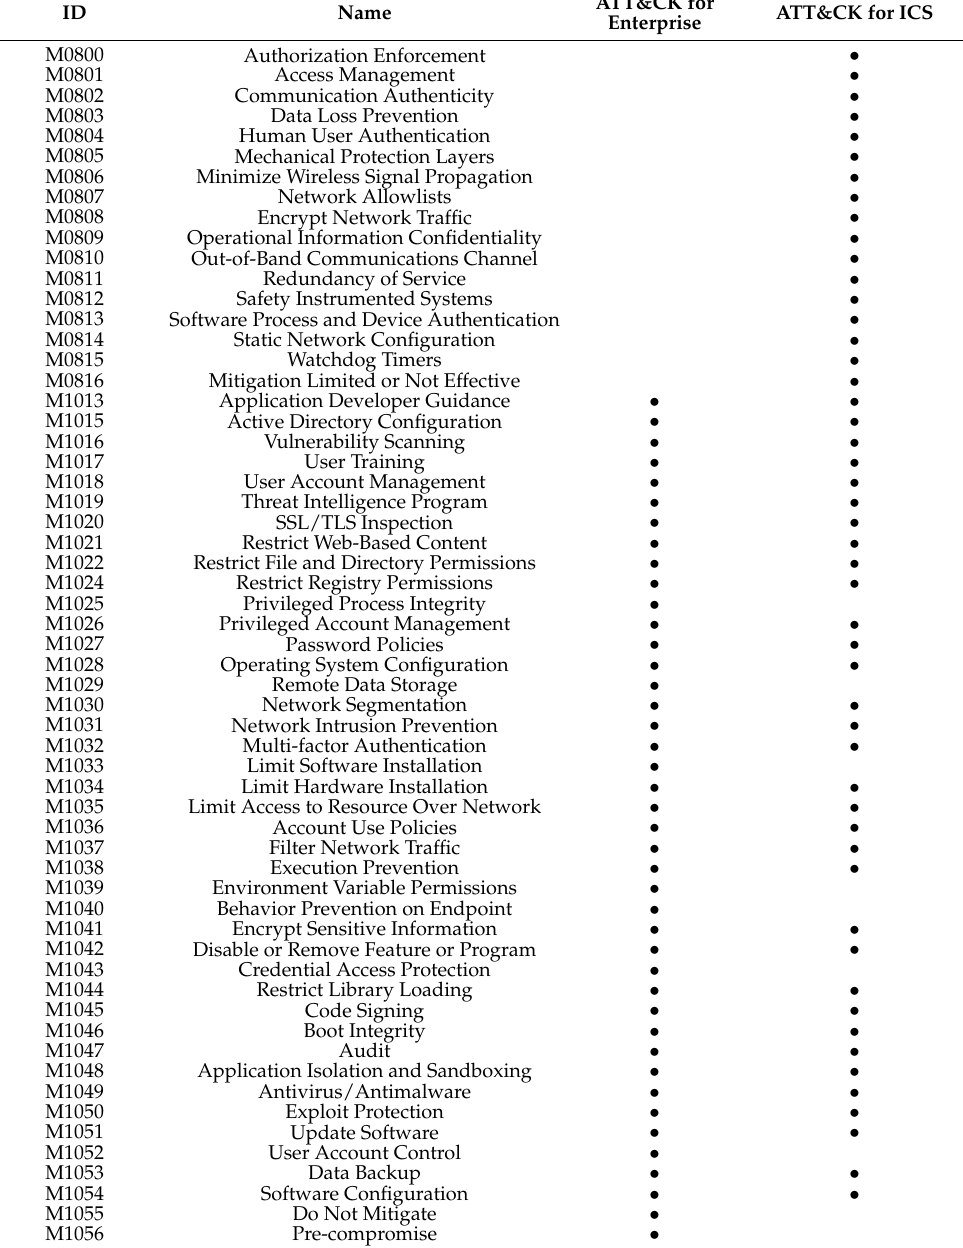
Table 1. MITRE ATT&CK for the Enterprise and ICS Mitigations